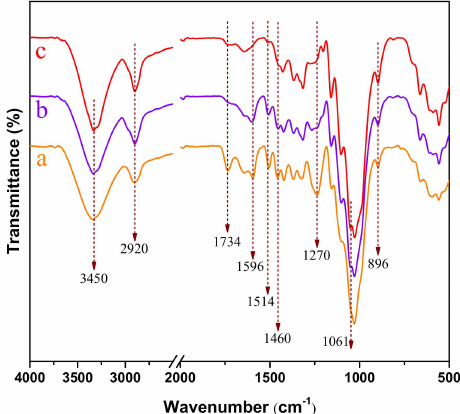
Figure 6. FTIR spectra of poplar wood under di ff erent treatment conditions. ( a ) Raw material; ( b ) P ( c )